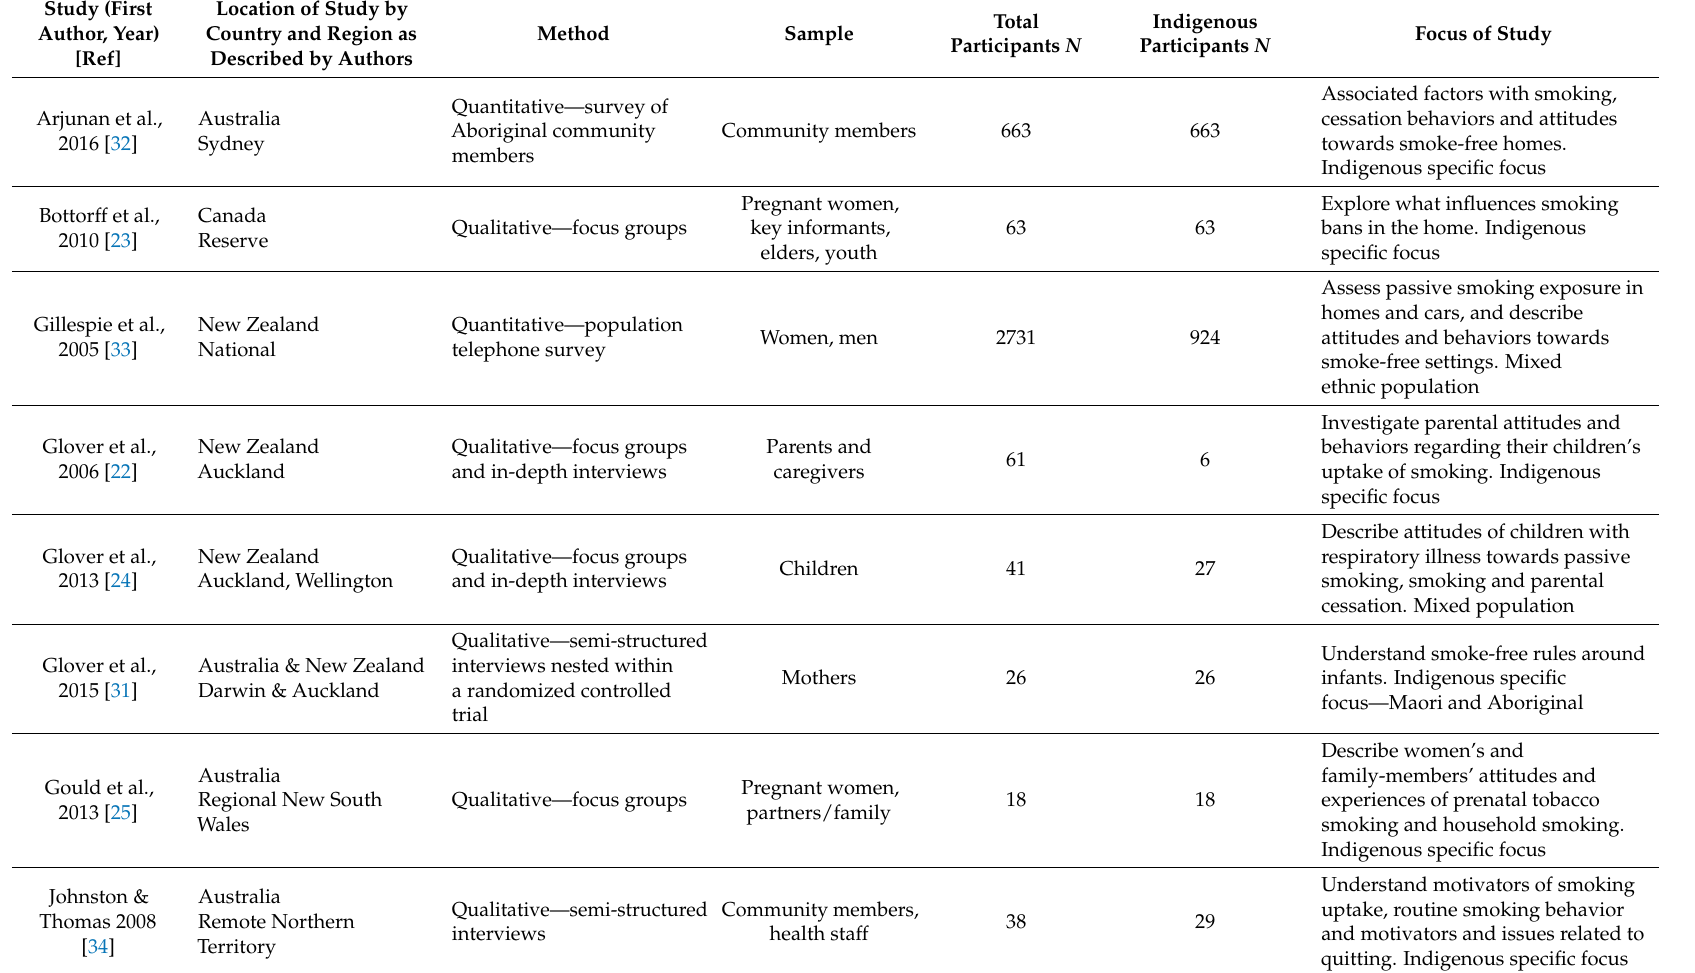
Table 1. Summary of characteristics of 15 included